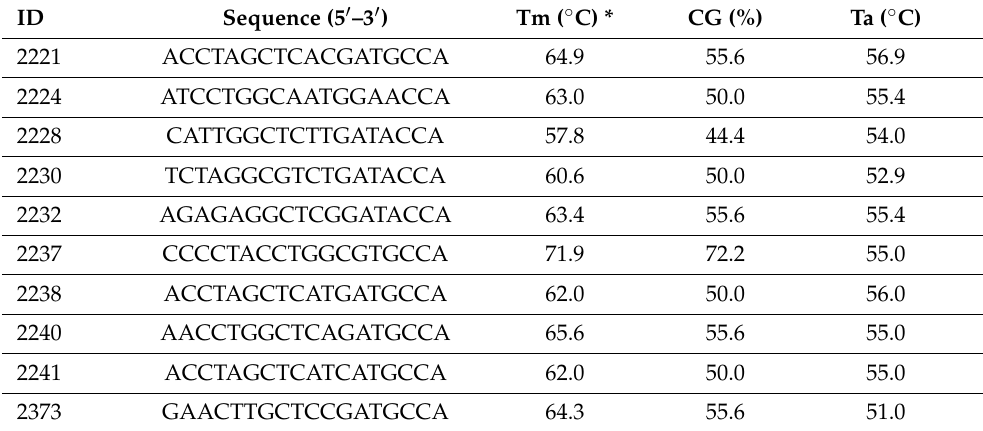
Table 7. PBS primers used in the analyses of genetic polymorphism of Rhodiola